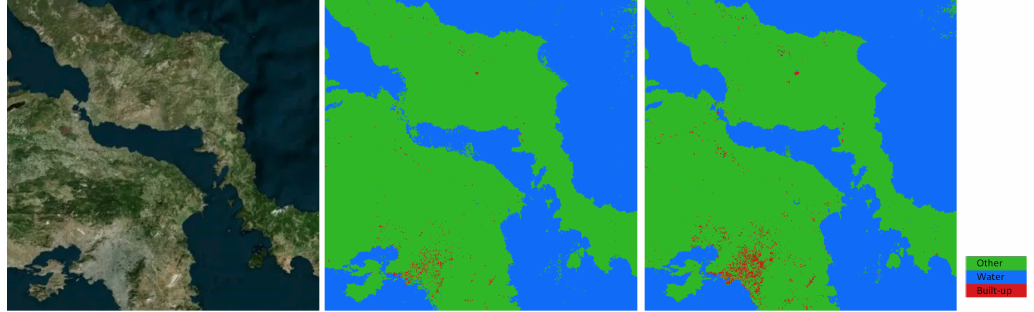
Figure 7. Testing model robustness on L2A product (geographic area in Europe). The columns from left to right: (i) RGB, (ii) 3-class CNN-segm, and (iii) 3-class CNN-dual